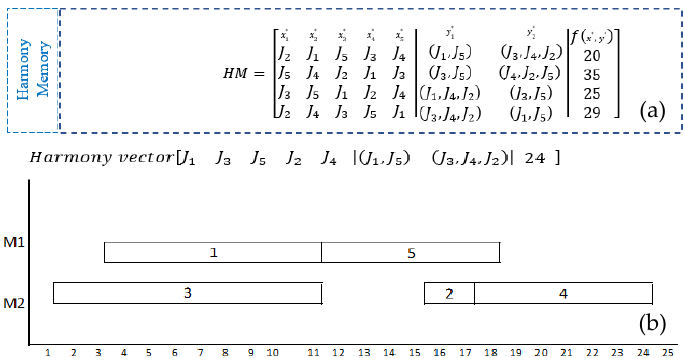
Figure 3. Harmony search examples for ( a ) an example of Harmony Memory; ( b ) visualized vector in Gantt chart.